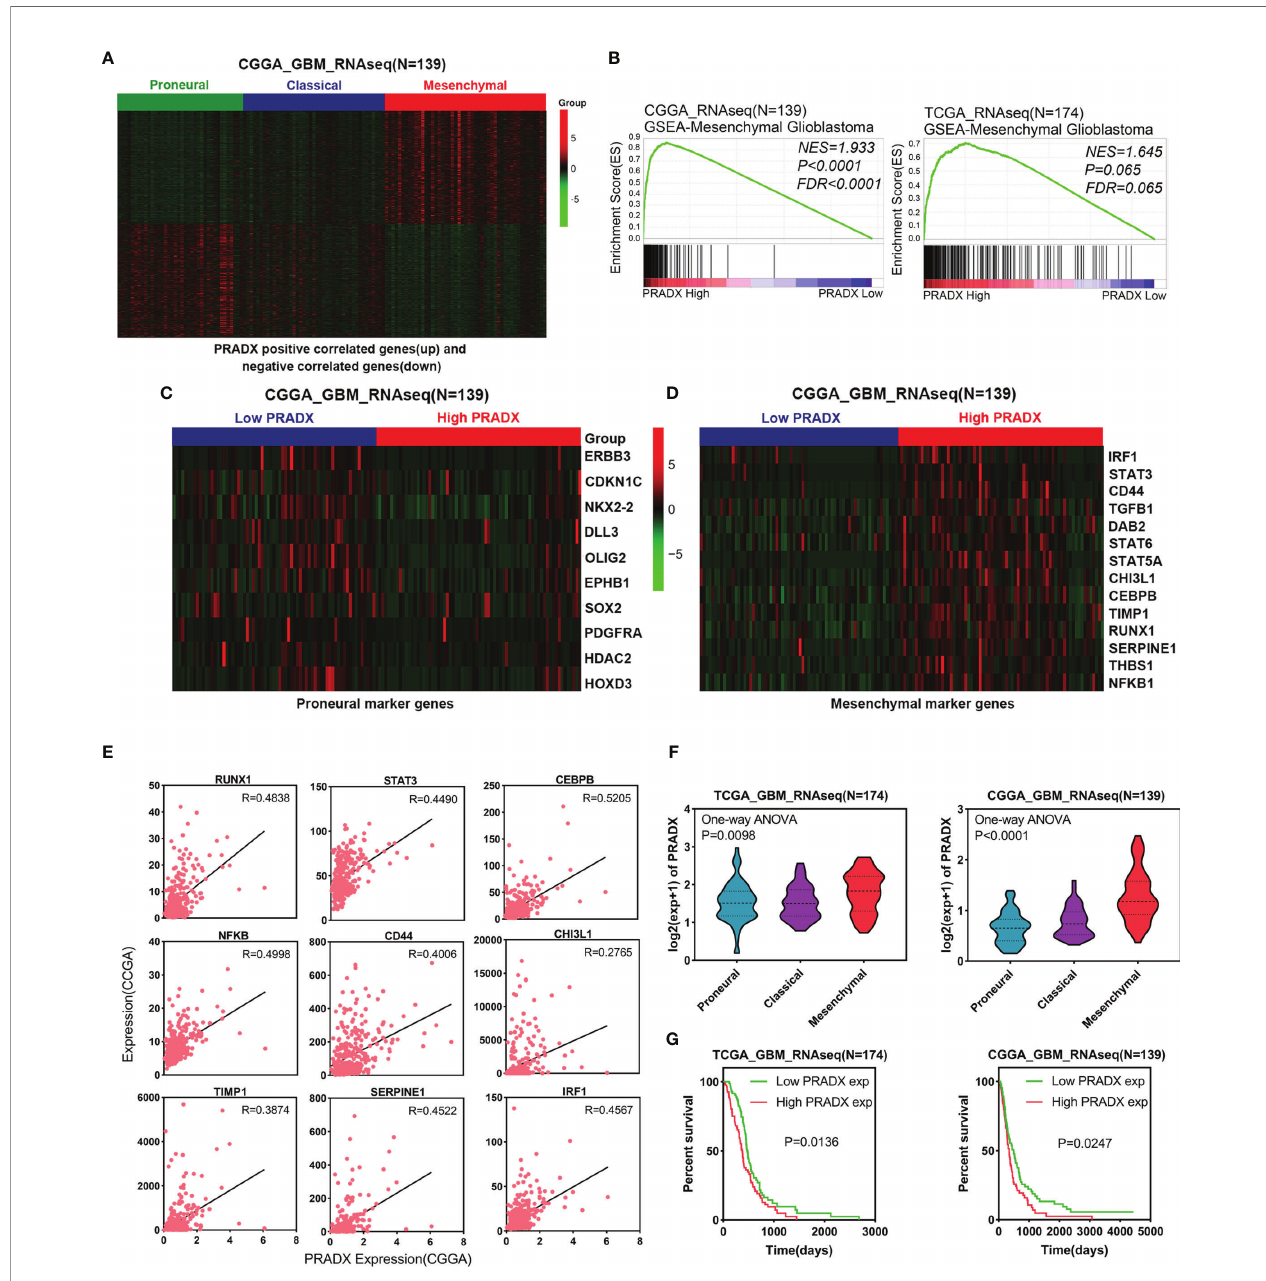
FIGURE 1 | PRADX expression correlates with mesenchymal GBM. (A) Clustered heat map showing that PRADX positively correlated genes (top 500) and negatively correlated genes (top 500) expression pro fi les in the CGGA database. (B) GSEA analysis of mesenchymal GBM gene expression between PRADX high and low expression groups in TCGA and CGGA databases. (C, D) Clustered heat map showing that proneural and mesenchymal marker genes expression pro fi les in PRADX high expression and low expression patients. (E) The correlation between PRADX and mesenchymal marker genes in the CGGA database. (F) Violin plots exhibiting PRADX expression in different molecular subtypes of GBM in TCGA and CGGA databases. (G) Kaplan-Meier curve showing patients ’ survival times between PRADX high expression and low expression